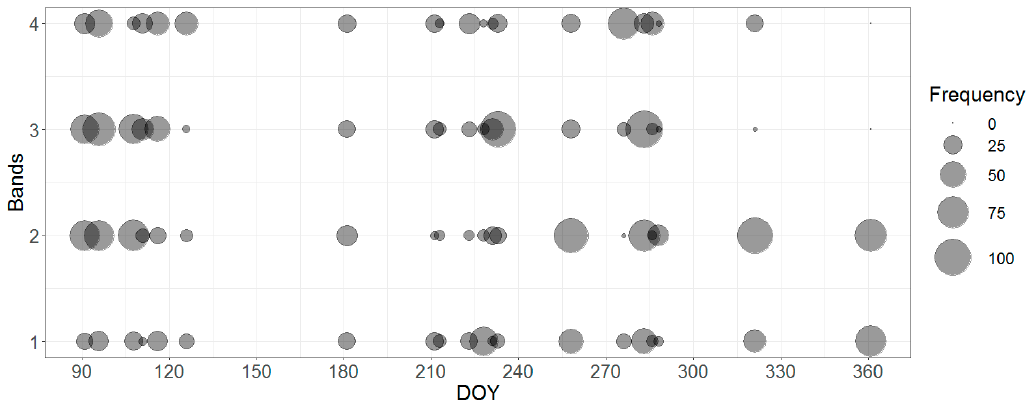
Figure 10. Selected frequency of a specific band and date. Band numbers 1, 2, 3, and 4 indicate red, green, blue, and near-infrared (NIR), respectively.